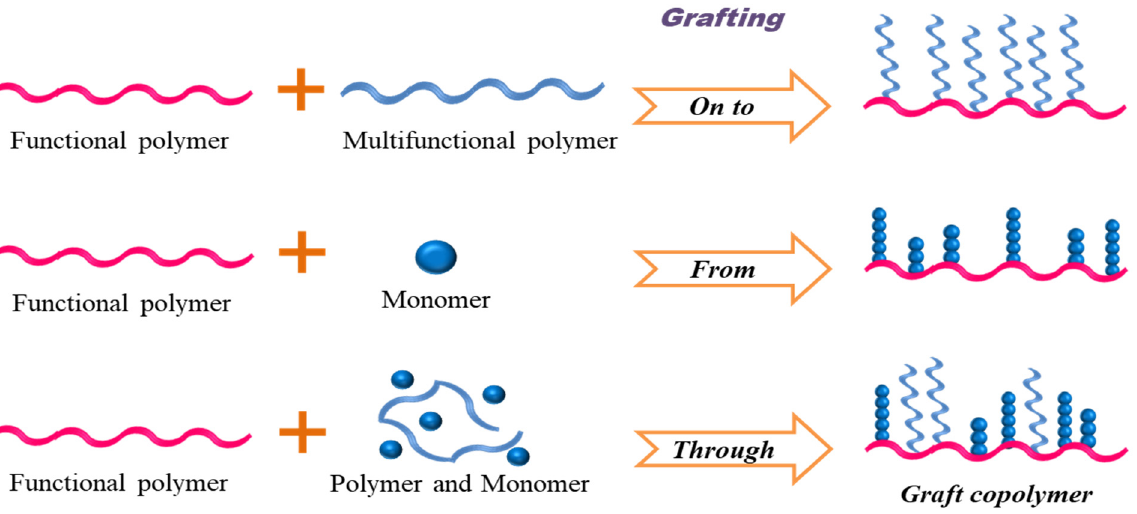
Figure 3. Polymer “Grafting” from various methods.